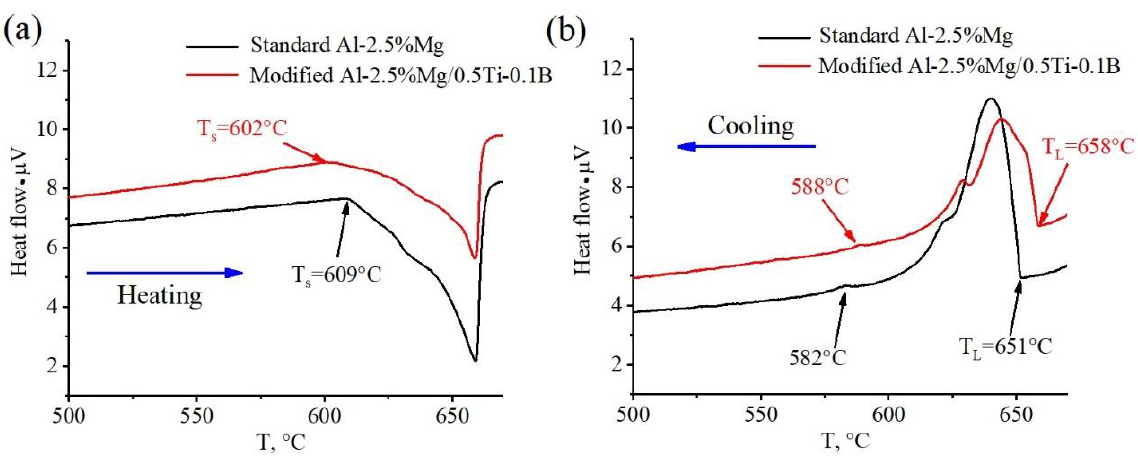
Figure 7. DSC analysis of the investigated alloys ( a ) heating curves and ( b ) cooling curves.